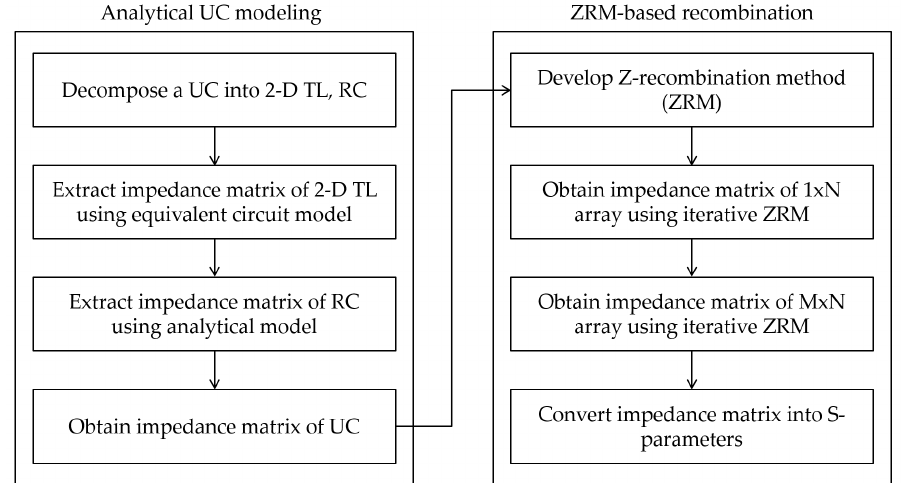
Figure 2. The procedure of the proposed unit-cell-based domain decomposition method (UC-DDM) using analytical equations of the unit cell (UC) and impedance-parameter recombination method (ZRM) for computationally efficient simulations of parallel plate noise (PPN) suppression in high-speed printed circuit boards (PCBs).